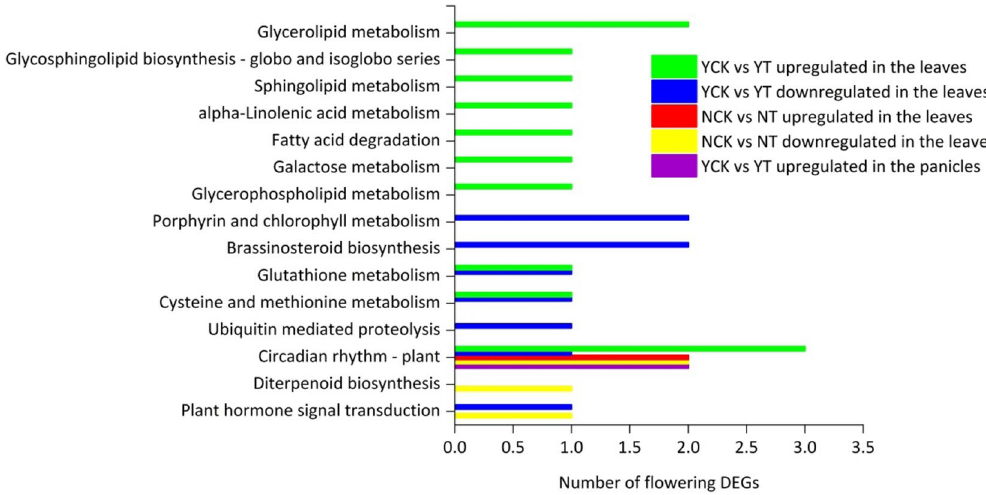
Figure 2. KEGG pathways of the flowering DEGs in the leaves and panicles of Ninggeng 4 and Yongyou 538 in response to different sowing dates. This figure was created using Origin 2021.